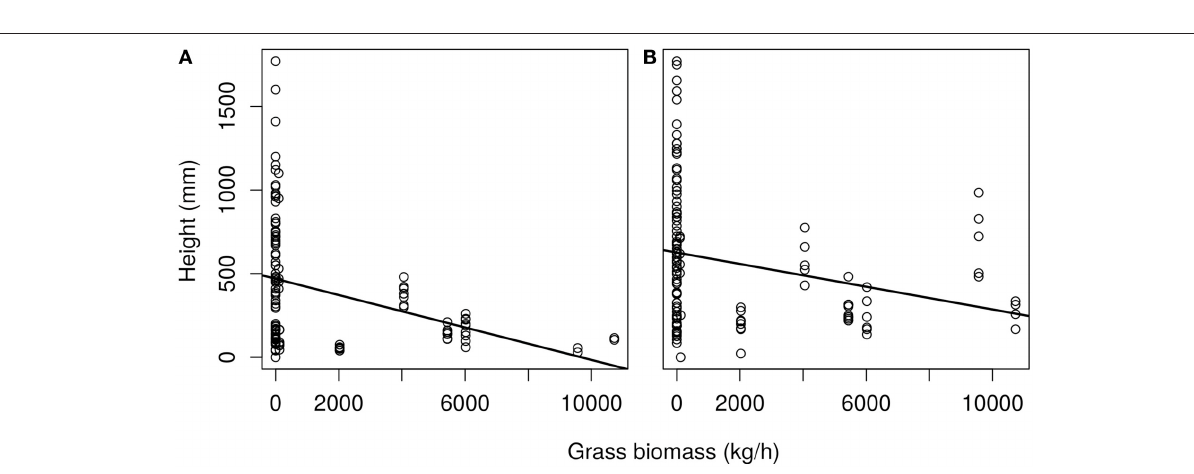
FIGURE 6 | Height of saplings (750 days old) plotted against average grass biomass of the site for (A) C. mopane and (B) S. nigrescens. Final plant height significantly declined as grass biomass increased for C. mopane F (1.121) = 8,835, p < 0.01 and S. nigrescens F (1,129) = 1,993 p < 0.05. Linear equation for (A) is y = − 0.048 + 468.87 and (B) y = − 0.03 +